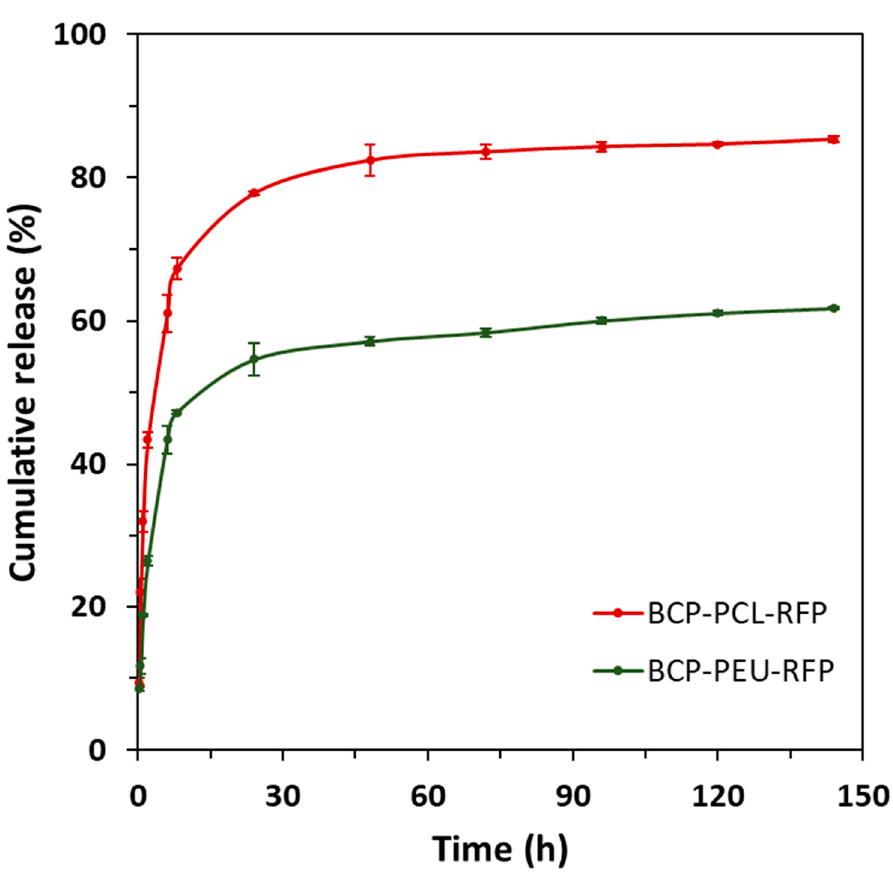
Figure 4. In vitro release profiles of RFP from the BCP scaffolds coated with PCL and PEU, in PBS (pH = 7.4), at 37 °C. Table 1. Exponent ( n ), constant ( k ) and correlation coefficient ( R 2 ) obtained from the Korsmeyer– Peppas model for the release of RFP from the BCP scaffolds coated with PCL and PEU. Scaffold